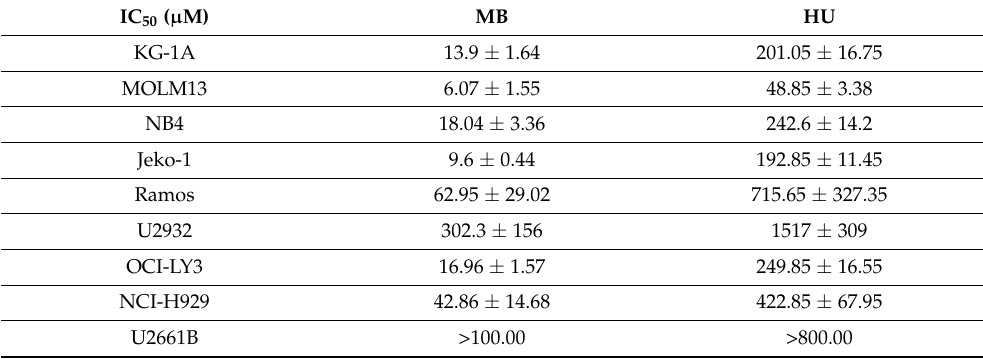
Table 1. Statistics of MTT IC 50 values.